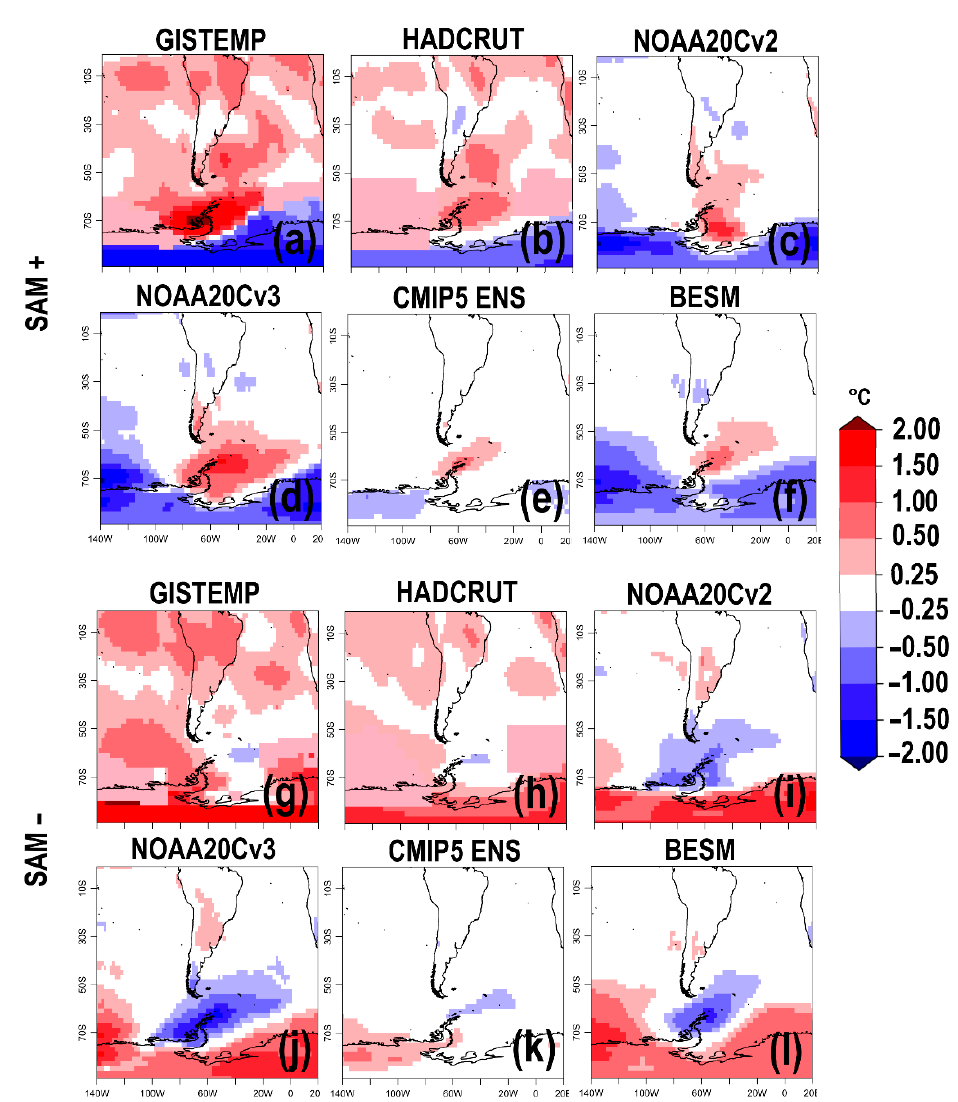
Figure 7. Surface temperature anomalies composites according to SAM phases. ( a – f ), positive SAM; ( g – l ), negative SAM. Composites were obtained by averaging temperature anomalies in months with SAM standardized index values higher than |2|. Temperature values are in celsius (°C). Datasets: ( a , g ), Marshall SAM index and GISTEMP; ( b , h ), Marshall SAM index and HadCRUT; ( c , i ), NOAA-20Cv2; ( d , j ), NOAA-20Cv3; ( e , k ), CMIP5 ensemble meanr. Supplementary Materials: The following are available online at www.mdpi.com/xxx/s1, Figure S1: SAM GW99 index absolute error compared with the observational reconstruction fromthe Marshall index (Figure 1). Figure S2: DJF precipitation anomalies composites according to SAM phases. Fig- ure S3: MAM precipitation anomalies composites according to SAM phases. Figure S4: JJA precipi- tation anomalies composites according to SAM phases. Figure S5: SON precipitation anomalies composites according to SAM phases. Figure S6: DJF surface temperature anomalies composites according to SAM phases. Figure S7: MAM surface temperature anomalies composites according to SAM phases. Figure S8: JJA surface temperature anomalies composites according to SAM phases. Figure S9: SON surface temperature anomalies composites according to SAM phases.